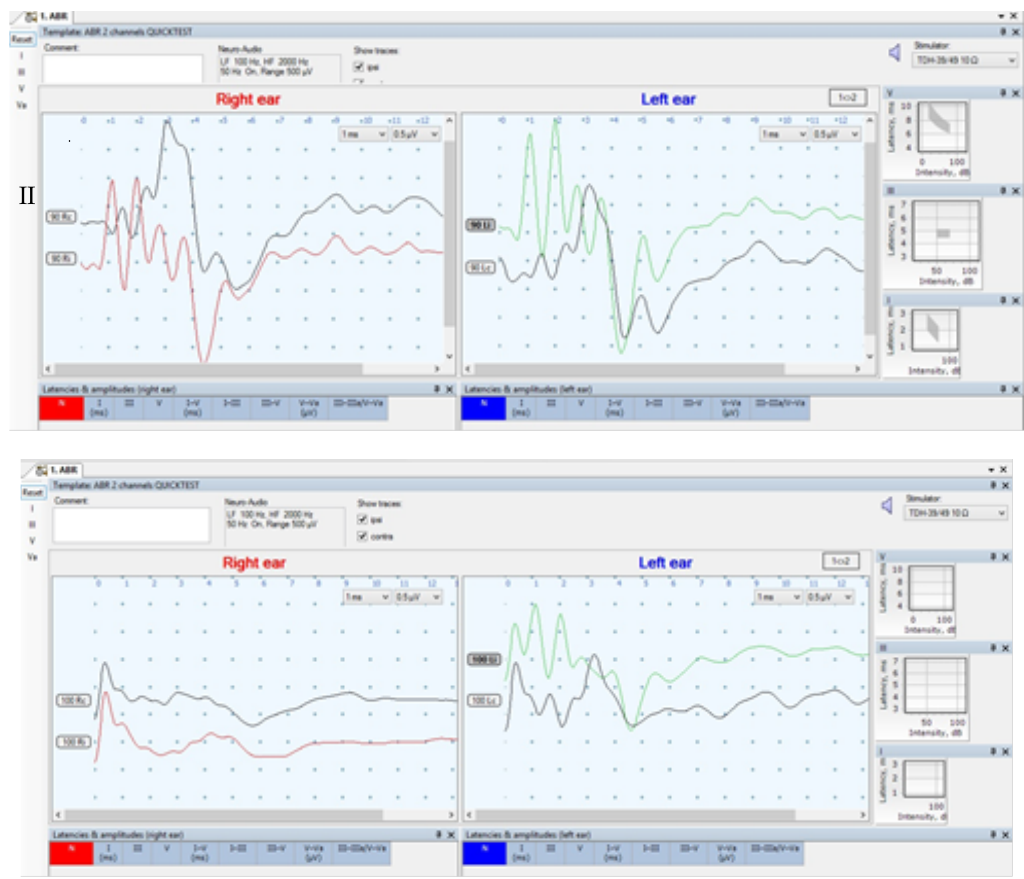
Fig. 2 Right ear